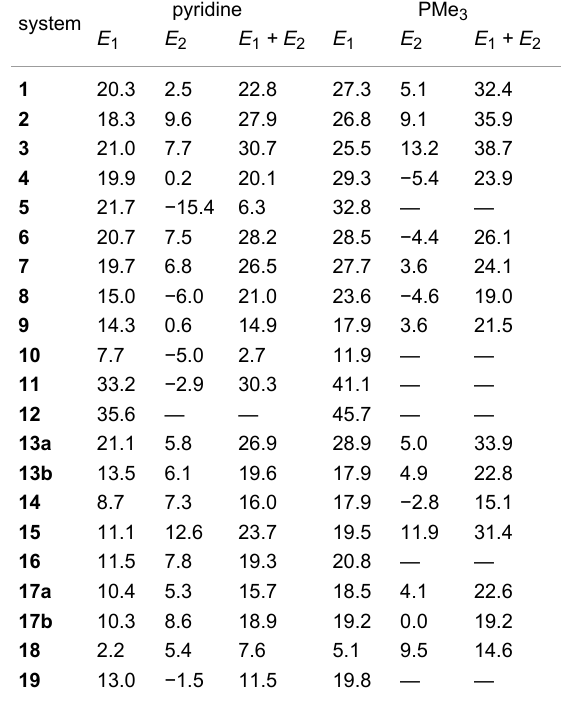
Table 1: Binding energy, in kcal/mol, of the first, E 1 , and of the second, E 2 , pyridine/PMe 3 molecule to the naked 14e species 1 – 13